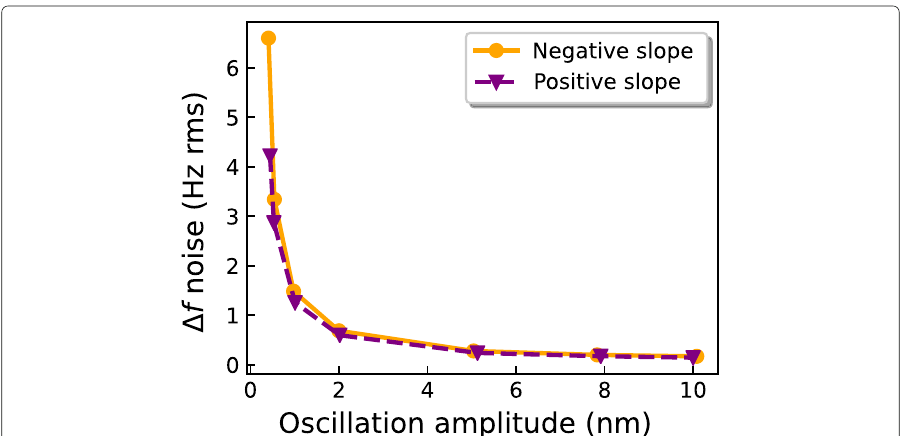
Fig. 10 Frequency shift noise ( (cid:5) f ) as a function of oscillation amplitude of cantilever being driven via optical excitation at 77 K. (cid:5) f is measured on the negative slope (orange circle) and positive slope (purple triangle) of the interference fringe. The lines are a guide to the